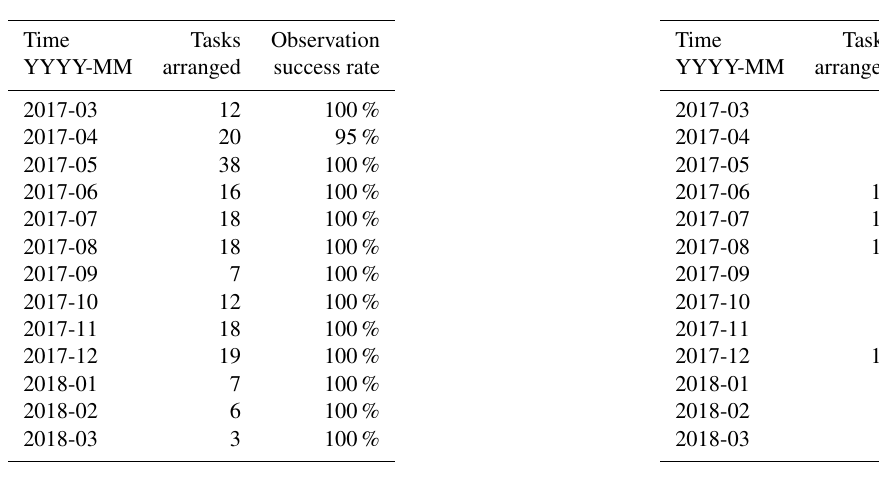
Table 14. Statistics of AGRI moon tasks. Table 15. Statistics of GIIRS moon